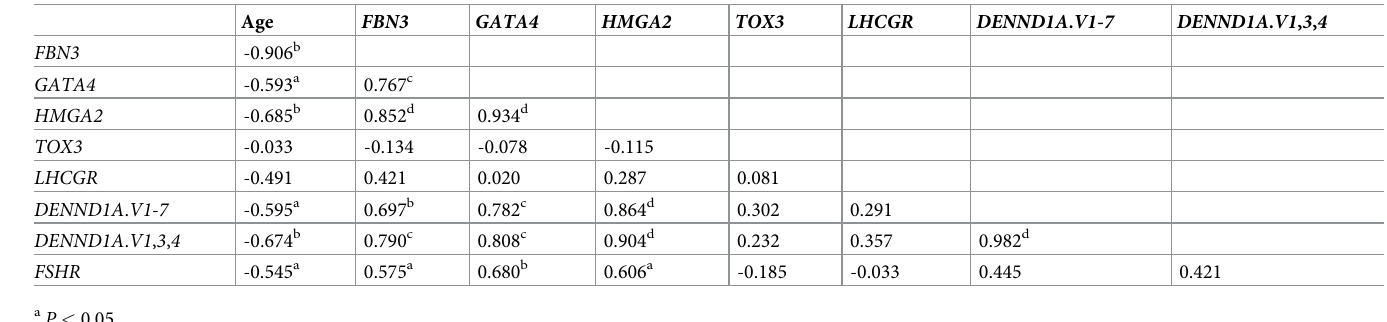
Table 1. Pearson correlation coefficients (r) of mRNA expression levels of PCOS-candidate genes in human fetal ovaries and their gestational ages (n =